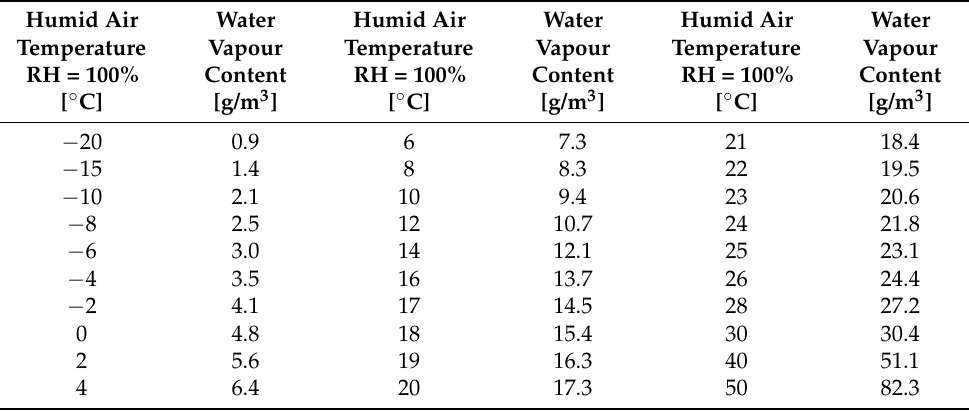
Table 1. Water vapour content in the air with the maximum humidity depending on temperature